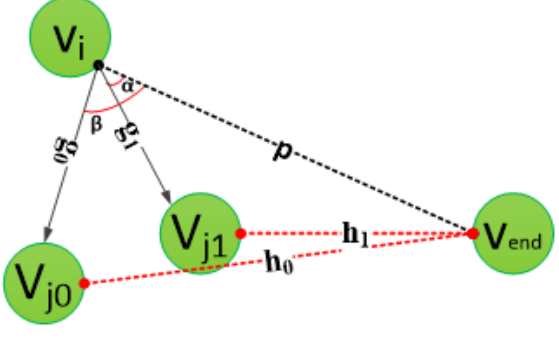
Figure 5. The influence of the search direction on the evaluation